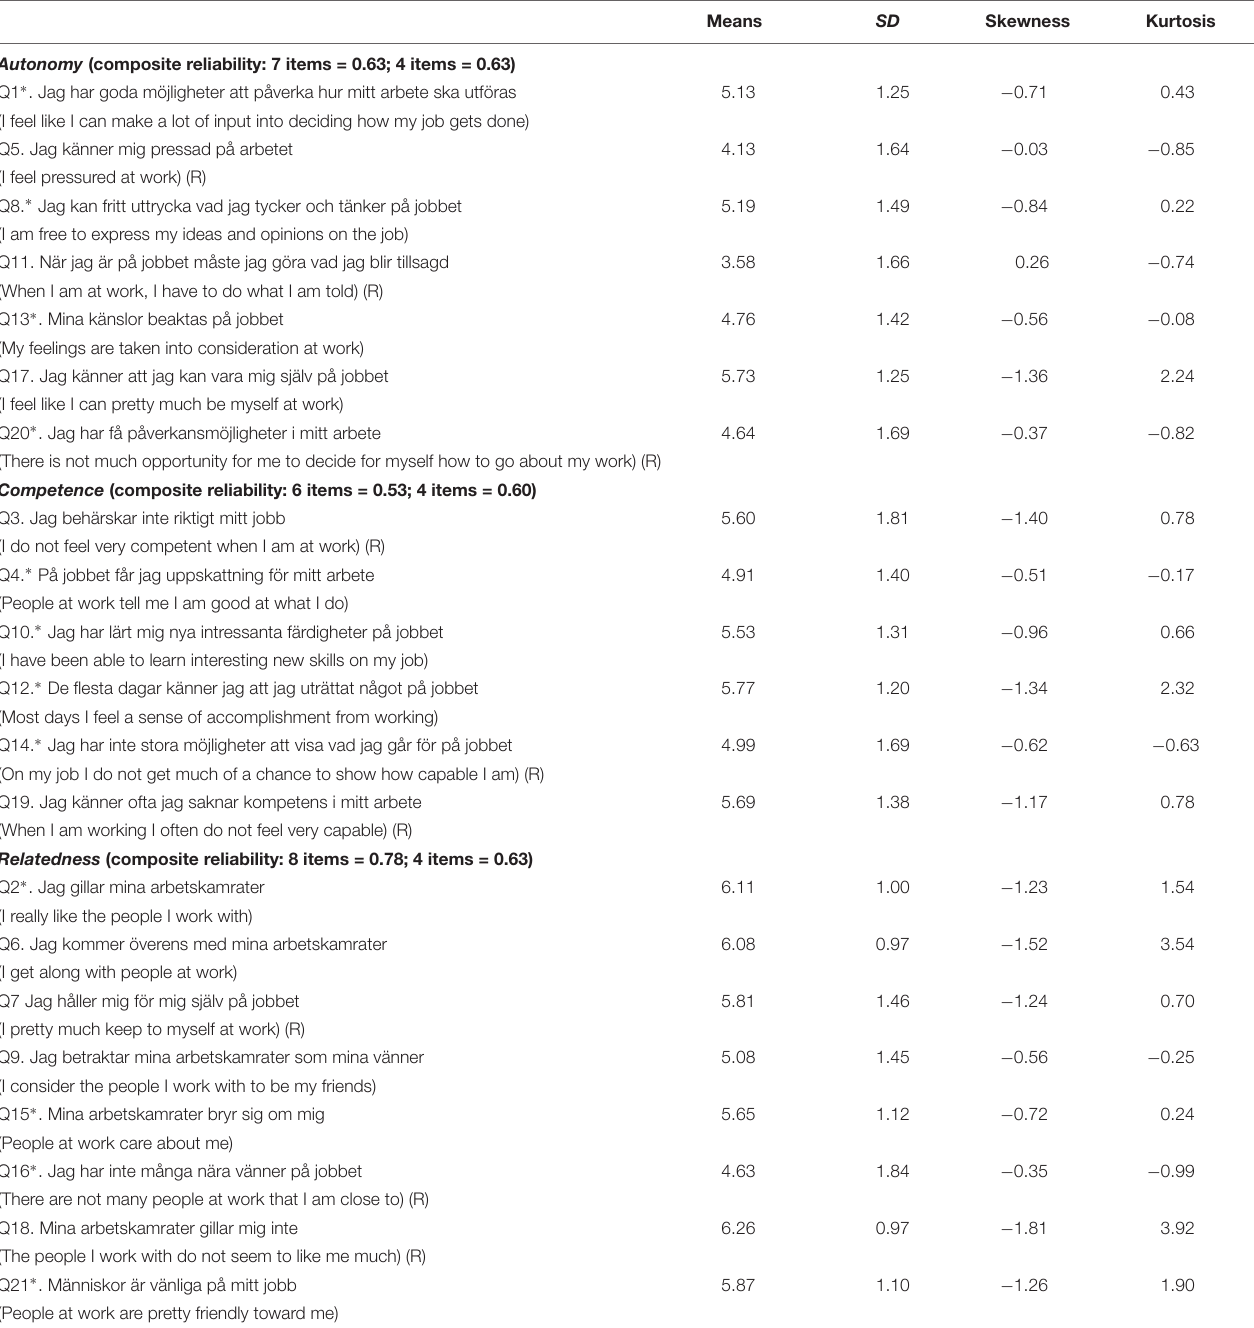
TABLE 1 | Multivariate normality of the BPNS items ( N = 1,200).